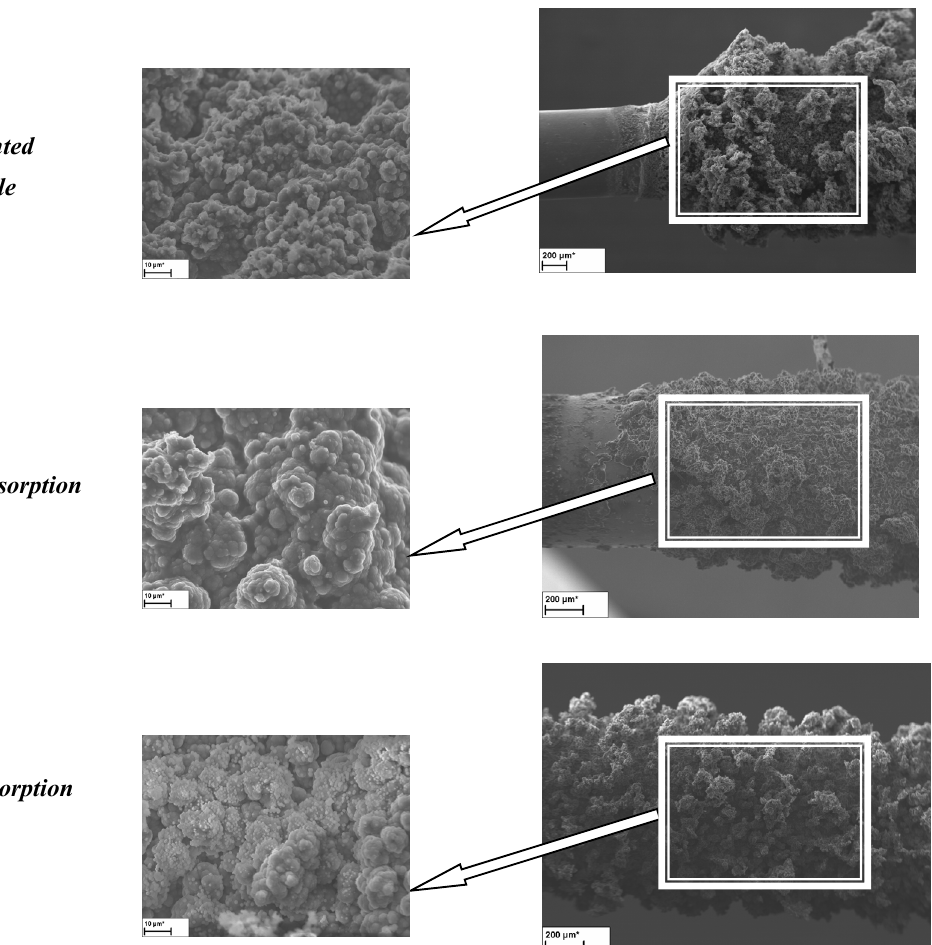
Figure 2. Microscopic photos of fibers with polythiophene coating during various stages of electropolymerization (for MET).